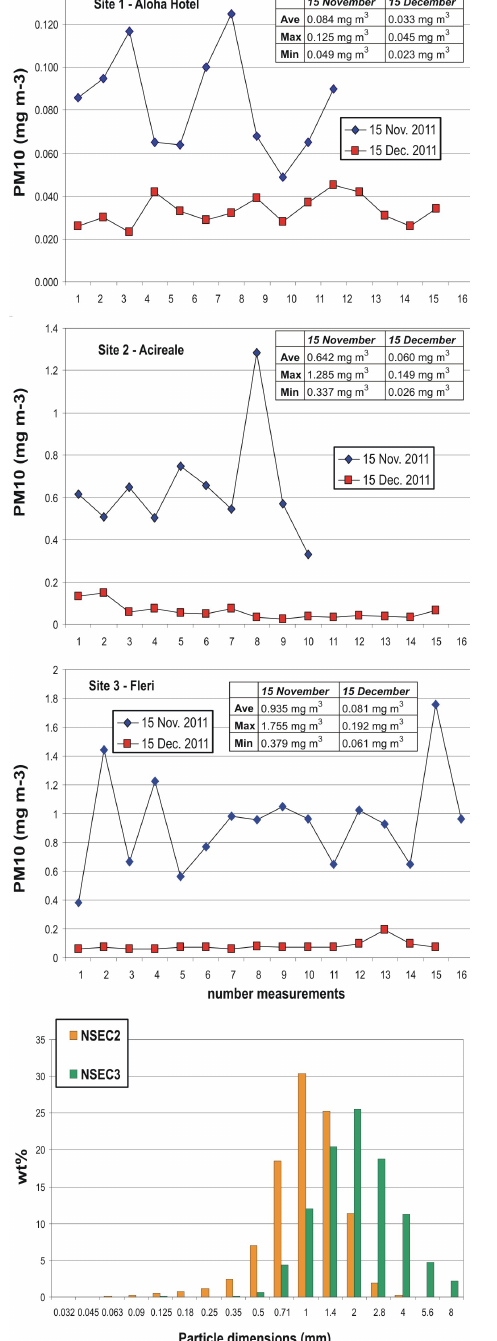
Figure 4. Panels (a, b, c) show PM 10 measurements in three stud- ied sites: (a) site 1, Aloha Hotel; (b) site 2, Acireale; (c) site 3, Fleri. The time interval of the number measurements is 1min. Blue lines and diamonds represent values measured in the afternoon of 15 November 2011, a few hours after the tephra fallout; red lines and squares represent values measured on 15 December 2011, in absence of a volcanic event. At the side of each plot the main PM 10 statistics data are reported. Ave is the average value; Max is the maximum value; Min is the minimum value. (d) Grain-size his- tograms concerning samples NSEC2 and NSEC3.